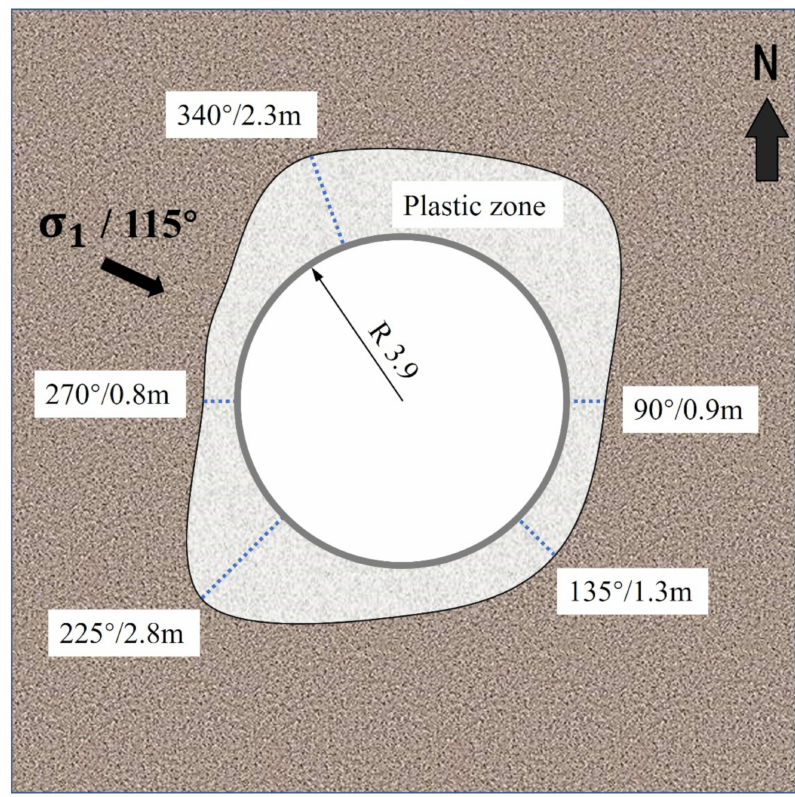
Figure 17. Delineation of the plastic region